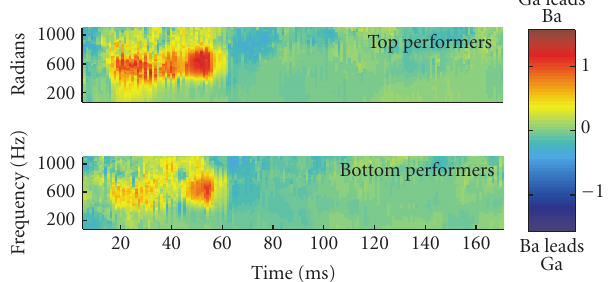
Figure 2: A phaseogram displaying differences in phase (radians, colorbar) in responses to /ba/ and /ga/ syllables, which have been synthesized so that they differ only in the second formant of the consonant-to-vowel transition. The top and bottom groups are children (ages 8 to 12) who differ on a speech-in-noise perception measure, the Hearing in Noise Test (HINT). The red color indicates greater phase difference, with /ga/ preceding /ba/, as expected given cochlear tonotopicity. Note that phase differences are only present in the transition, not in the steady state, during which the syllables are identical. Modified from